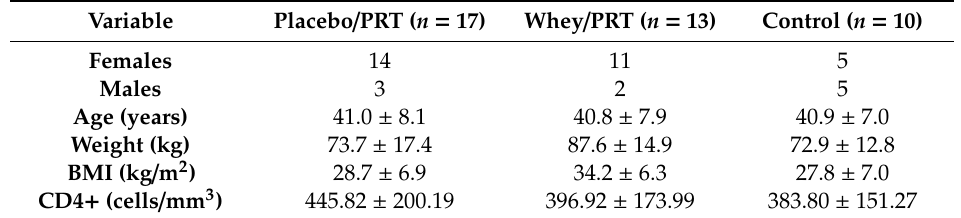
Table 1. Baseline characteristics of human immunodeficiency virus (HIV)-infected participants on antiretroviral therapy